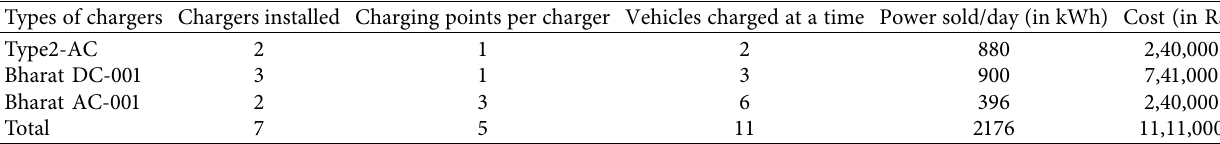
Table 9: Commercial slow charging station [131].